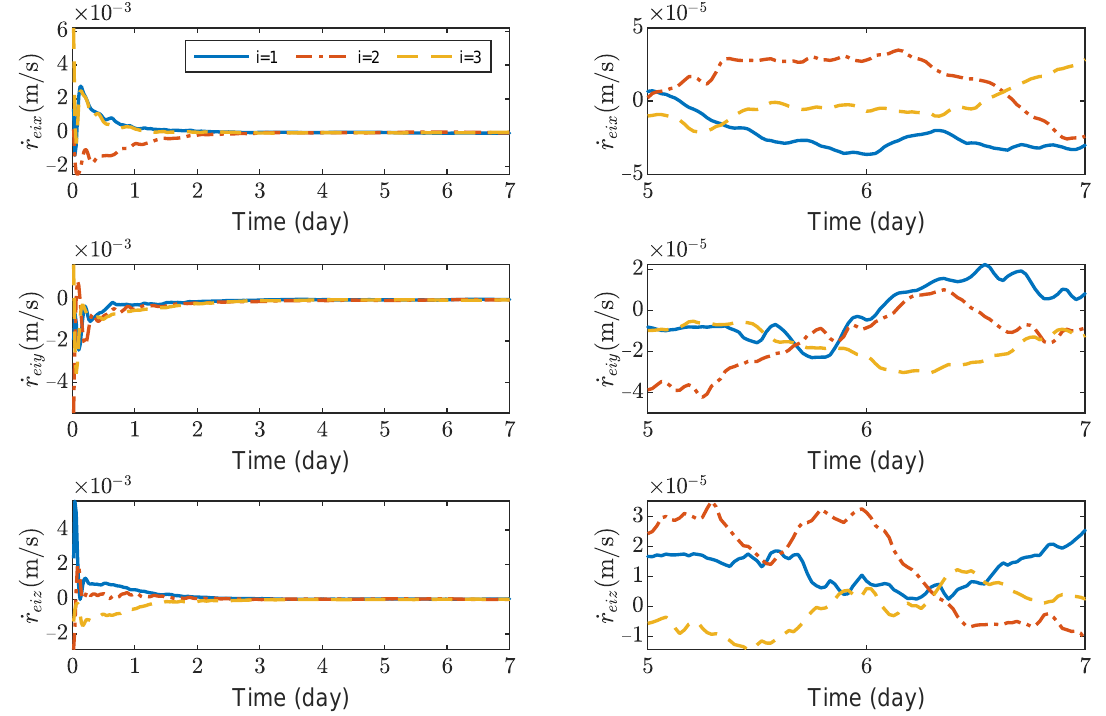
Figure 4. Relative linear velocity errors of spacecraft SC1 ∼ 3, the max control force of spacecraft is 100 µ